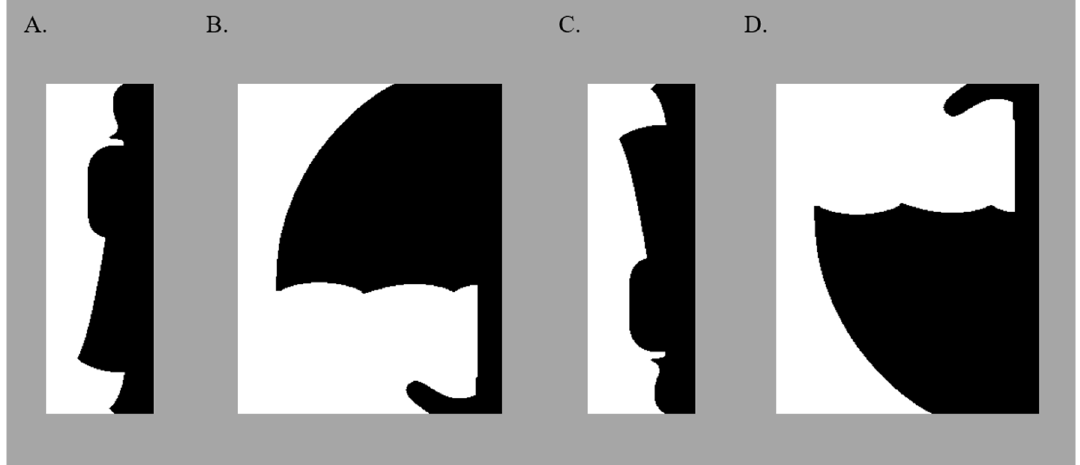
Figure 1. Sample Bipartite Displays. In all stimuli, a portion of a well-known object was sketched on one “critical” side of the central border; this critical region was equally often on the left/right, in black/white, and upright/inverted. In these samples, the portions of the well-known objects are sketched on the right side of the central border in black (upright portions of a woman and an umbrella are shown in ( A ) and ( B ), respectively; inverted versions are shown in ( C ) and ( D ), respectively). Displays were presented on a medium gray background.